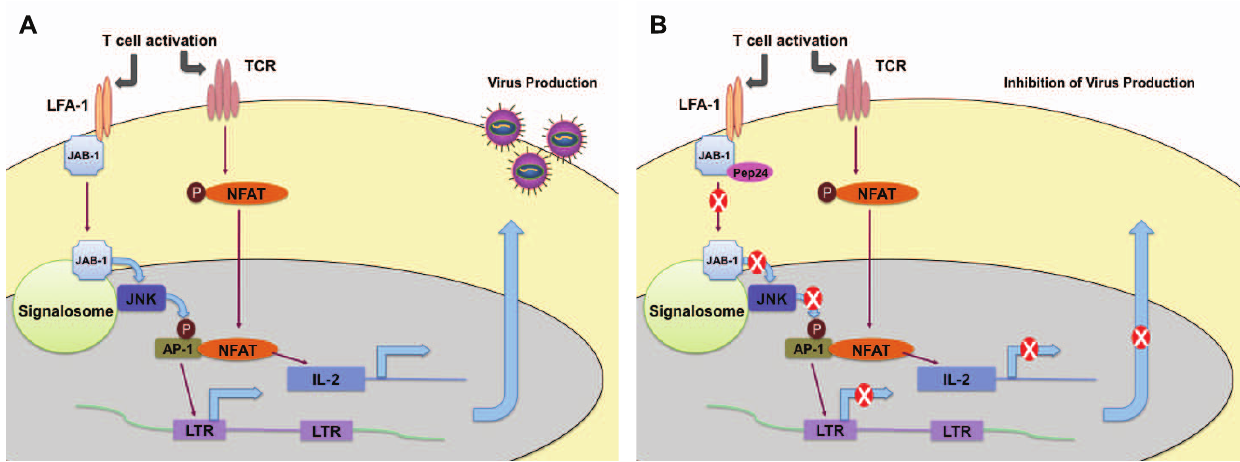
Figure 8. Proposed model for the inhibition of signalling pathway by Pep24. (A) After LFA-1 activation, JAB1 relocalizes into cytoplasm and nucleus, activates AP-1 and induces gene activation, and finally activates HIV-1 replication. (B) When Pep24 binds to JAB-1, JAB1 relocalization is blocked inhibiting downstream signals and HIV-1 replication.